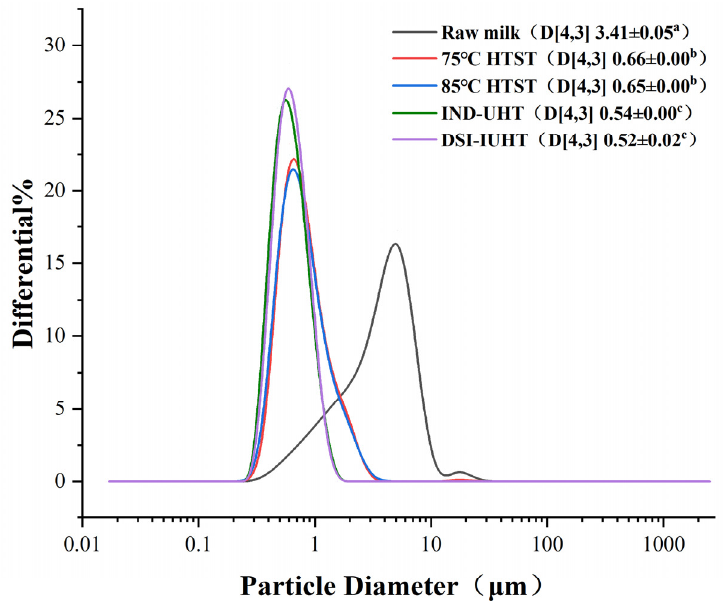
Figure 1. Particle sizes and distribution of the milk samples. The volume-weighted mean diameter (D[4,3]) used to characterize particle sizes. The different superscript letters of particle sizes indicate significant differences ( p < 0.05) (75 °C HTST, 75 °C 15 s high-temperature short-time pasteurization; 85 °C HTST, 85 °C 15 s high-temperature short-time pasteurization; IND-UHT, 143 °C 3–4 s indirect ultra-high temperature; DSI-IUHT, 143 °C 1–2 s direct steam injection instantaneous ultra-high tem- perature).